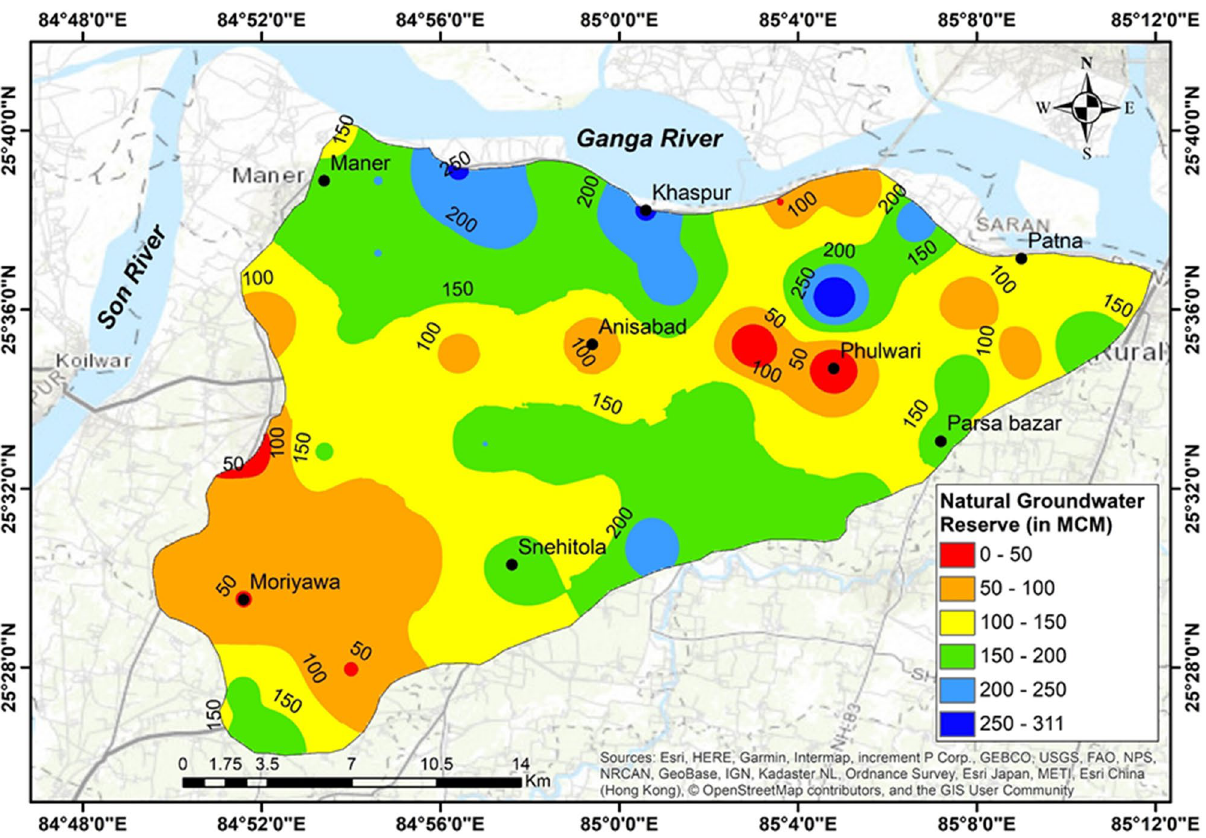
Figure 7. Groundwater reserve in a morphodynamic system at a part of Ganga basin, Northern India during the monsoon precipitation of the year 2019 (N.C.M.: sketched this figure with the help of ArcGIS Desktop 10.4, http:// www. esri.